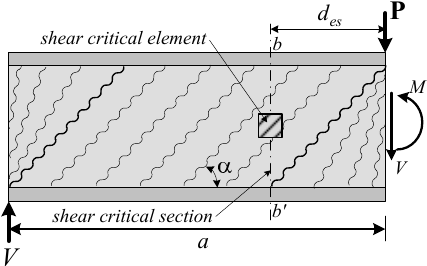
Figure 2. Shear critical element in a RC beam.